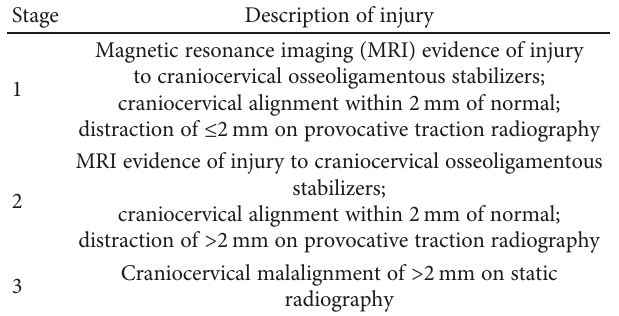
Table 1: Harborview classi fi cation for craniocervical injuries [10].